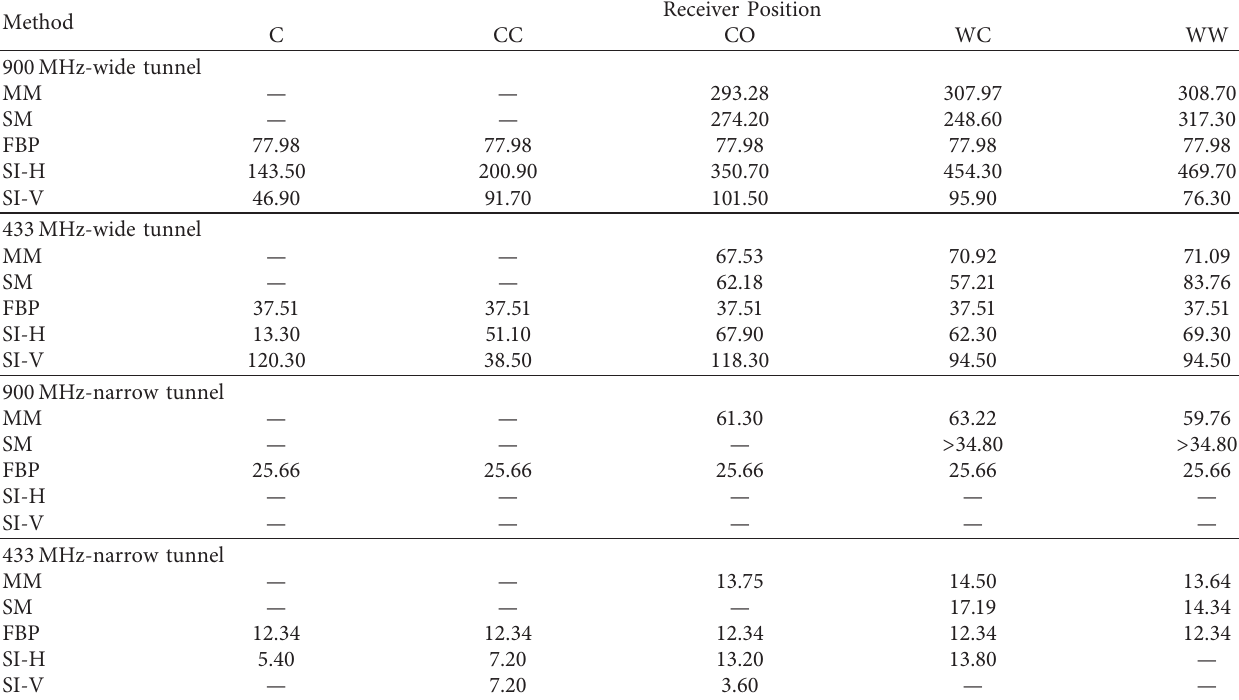
Table 7: Location of dividing point (in m).